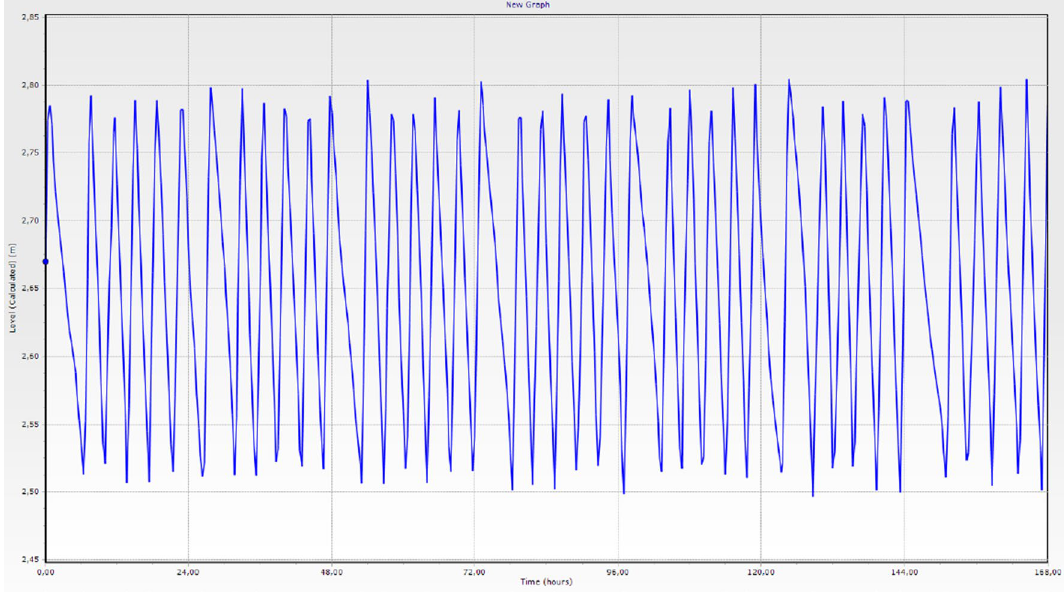
Fig. 10 Water level in one of the water tanks after the modernization of the main pump